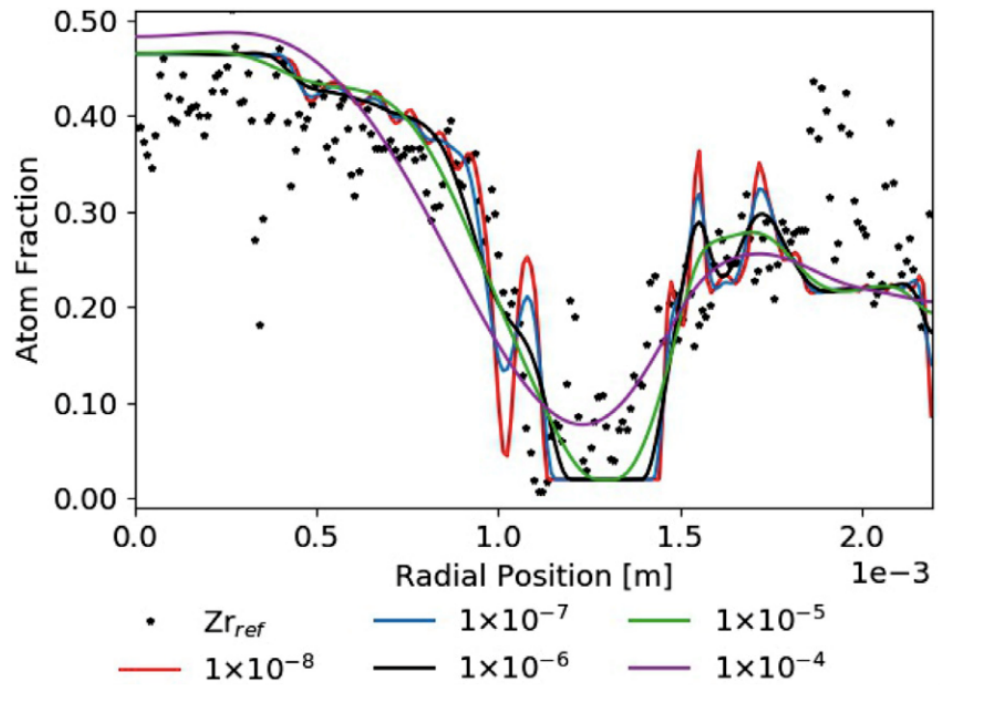
Figure 5. Radial Zr profile of metallic fuel with different tunable parameters, as reported by Hirschhorn et al.